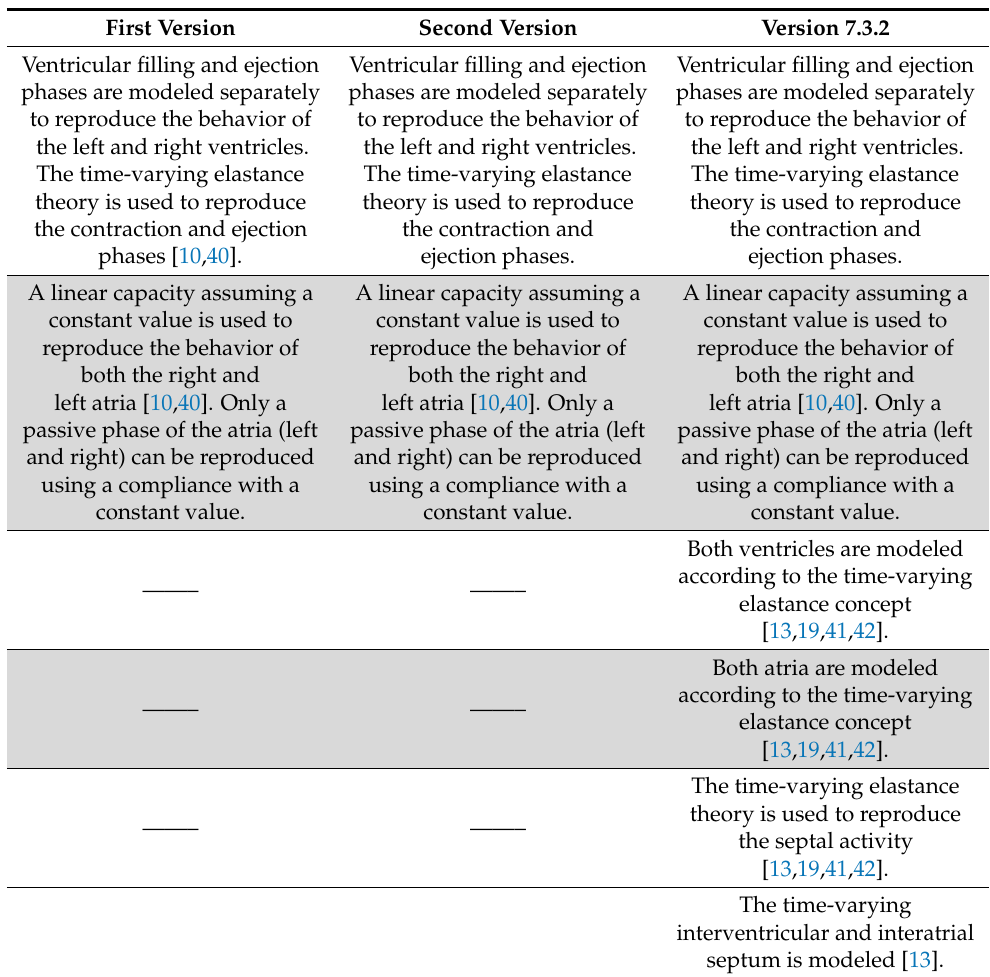
Table 1. Evolution over time of the ventricle, atrium and septum